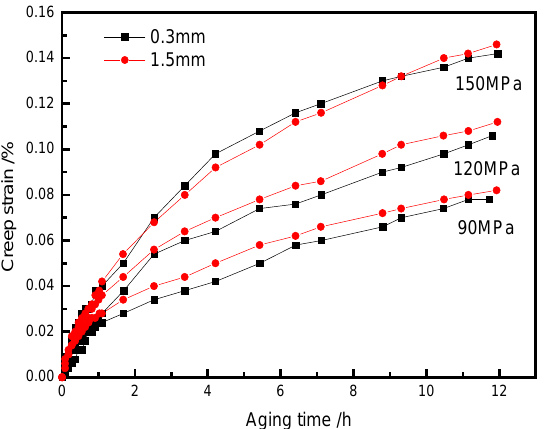
Figure 3. The comparisons of creep strain curves between 0.3 mm and 1.5 mm AA2024.